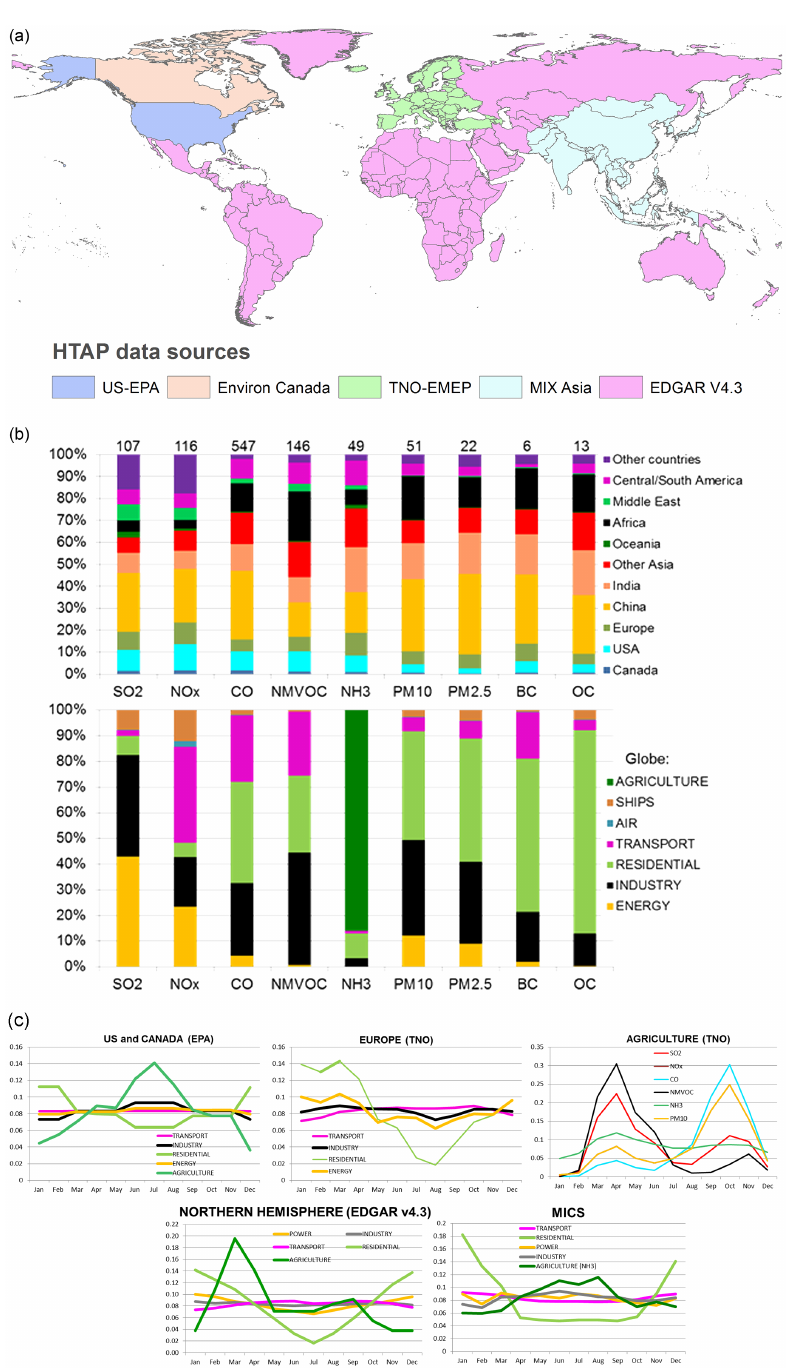
Figure 1. (a) Collection of regional emission inventories (US-EPA, Environ Canada, TNO-EMEP, MIX (MICS-Asia III), EDGARv4.3 for the global air pollutants and their use for world countries in data set HTAP v2.2 (b) Regional relative contribution to 2010 pollutant emissions (upper panel). Asian emissions have been divided into China, India and other Asia fractions from the MIX database. The region “rest of the world” has been disaggregated into Oceania, Africa, Middle East, Central/South America and other countries making use of the EDGAR v4.3 inventory. Global sector-specific anthropogenic emissions of gaseous pollutants and particulate matter components for the year 2010 (lower panel). Global absolute emissions are reported on top of each bar in Tg species per year. Large scale open-biomass burning is not included in the analysis. (c) Temporal profiles with relative factors varying around 1 / 12 and applied on the yearly emissions of the different data sources (US-EPA for US and Canada, EMEP-TNO for Europe with compound-specific variation of the agricultural temporal profiles, EDGAR temporal profiles for the Northern Hemisphere and MICS profiles for